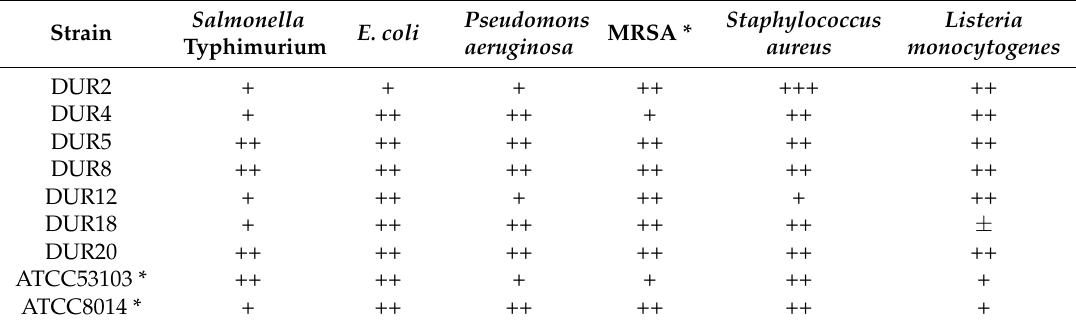
Table 6. Antibacterial effects of Lactobacillus using agar well diffusion assay against 6 pathogens. Staphylococcus Listeria Pseudomons Salmonella E. coli MRSA * Strain aureus monocytogenes aeruginosa Typhimurium